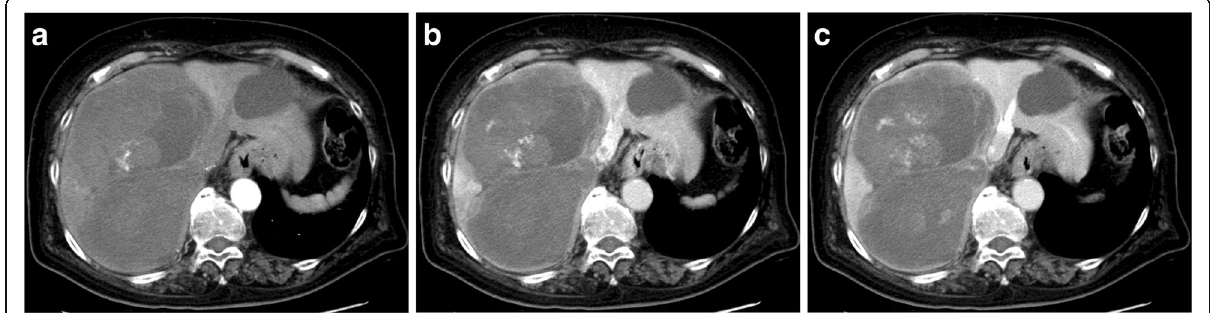
Fig. 1 Computed tomography images. A contrast-enhanced dynamic computed tomography image of a tumor 18 cm in diameter in the right hepatic lobe. a Arterial phase, b portal vein phase, and c equilibrium